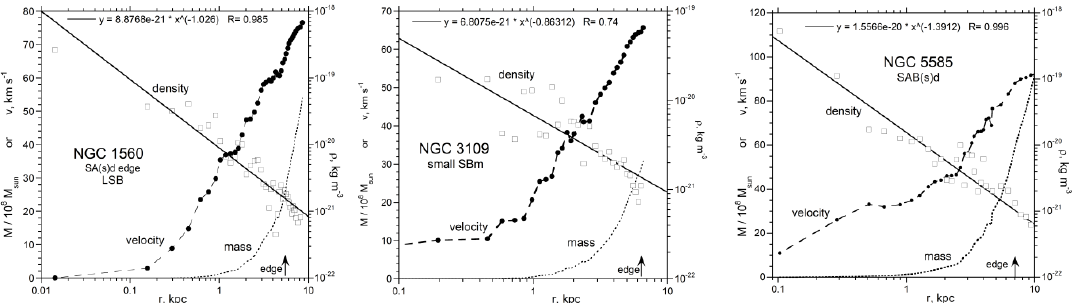
Figure A5. Three small spirals: RC data from Bottema and Pestaña [64].